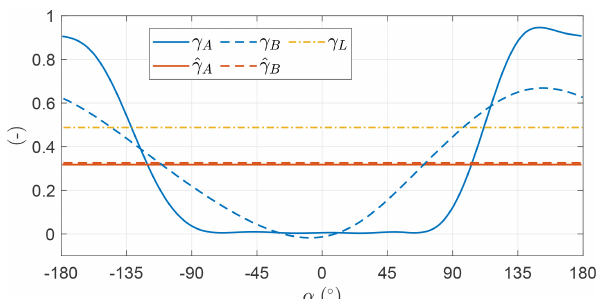
Figure 34. Optimal γ as a function of the angular